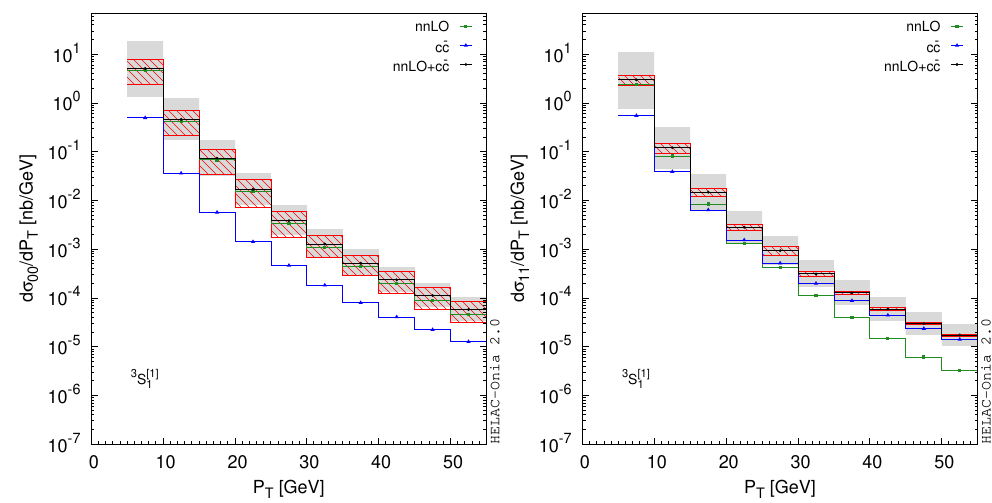
Figure 15 . Comparisons of spin-dependent differential cross section d(cid:27) between our nnLO calculations and the LO charmonium plus charm quark pair